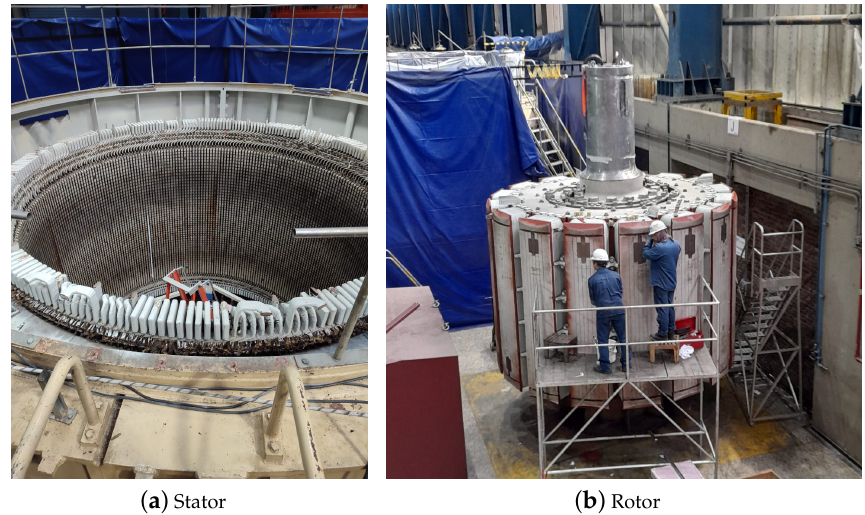
Figure 7. State of the previously overhauled Unit 5 stator and rotor. For reference, the rotor’s diameter is about 3